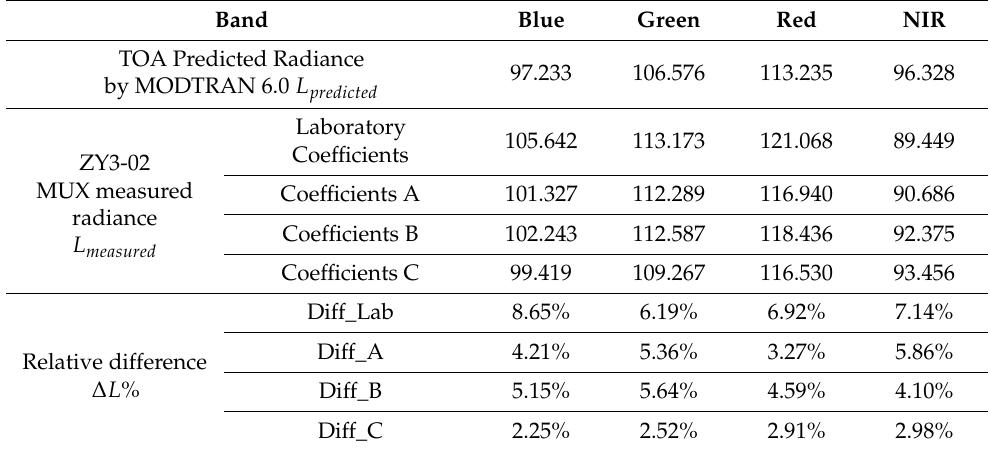
Table 7. The relative difference between the TOA predicted and measured radiance (in units of